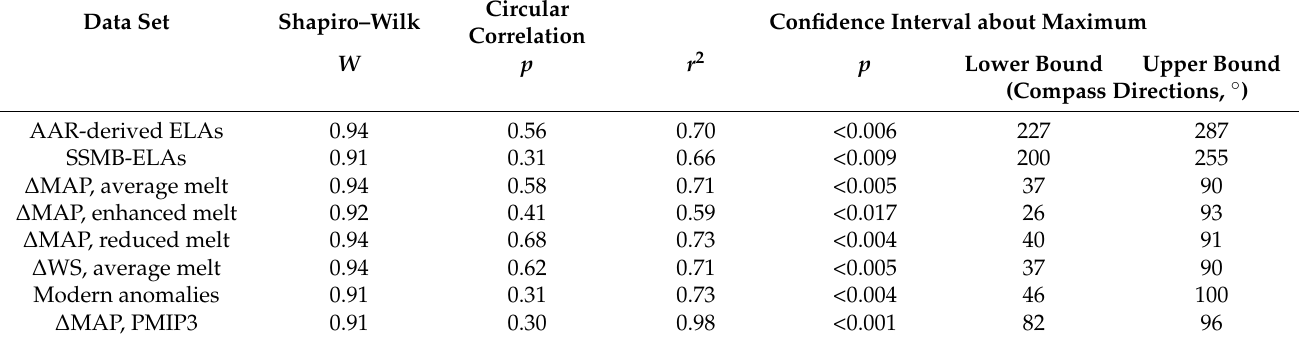
Table 4. Circular linear correlations of ELAs, required changes in precipitation to maintain steady-state mass balance (SSMB) of paleoglaciers under different scenarios, modern precipitation anomalies, and changes in precipitation indicated by PMIP3 ensembles, and 95% confidence intervals about maximums obtained by a cosinor technique. Null hypothesis that data are normally distributed is accepted when p values for Shapiro–Wilk criteria (test statistic is W ) exceed